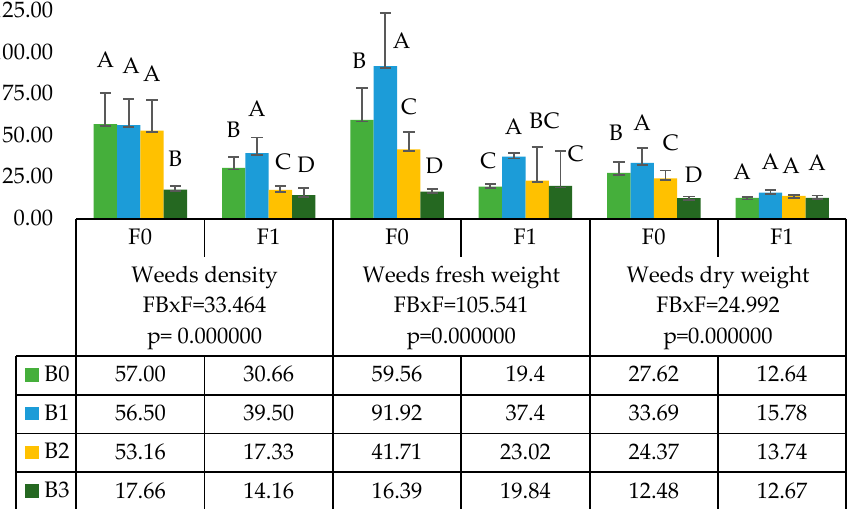
Figure 4. The influence of biochar (B0-0 t ha − 1 , B1-5 t ha − 1 , B2-10 t ha − 1 , B3-15 t ha − 1 ) and fertilization (F0—without fertilization, F1—optimal fertilization) interactions on weed incidence. FBXF—F-test for biochar–fertilization interaction, p–p value. Columns marked with different capital letters are statistically different using the protected least significant difference (LSD) test at P < 0.05.